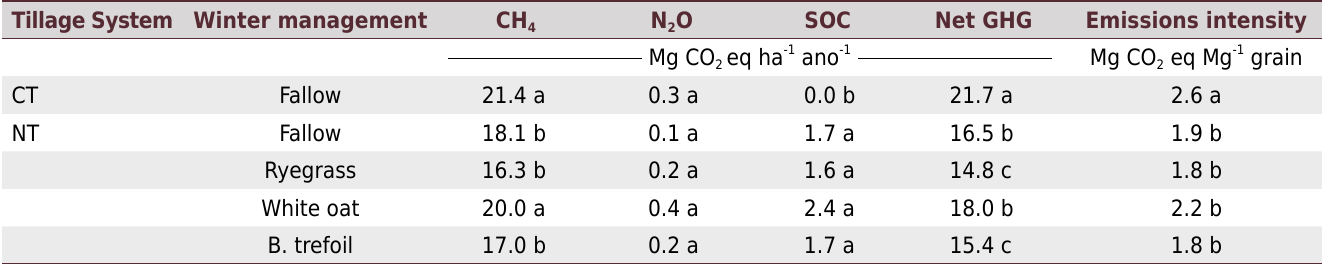
Different letters in the colunm indicate a significant difference between means of the treatment by Skott-Knott at 5 %